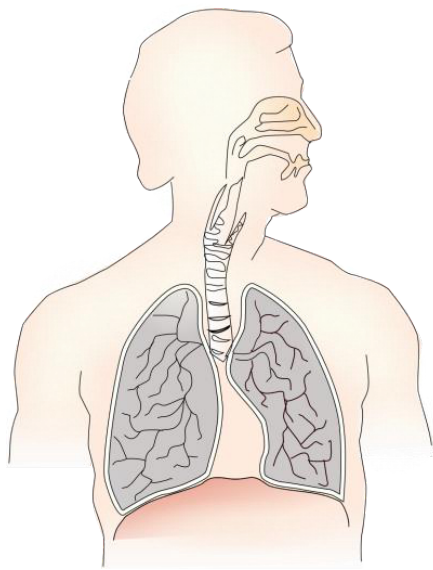
Figure 2. Structure of the chest and diaphragm.